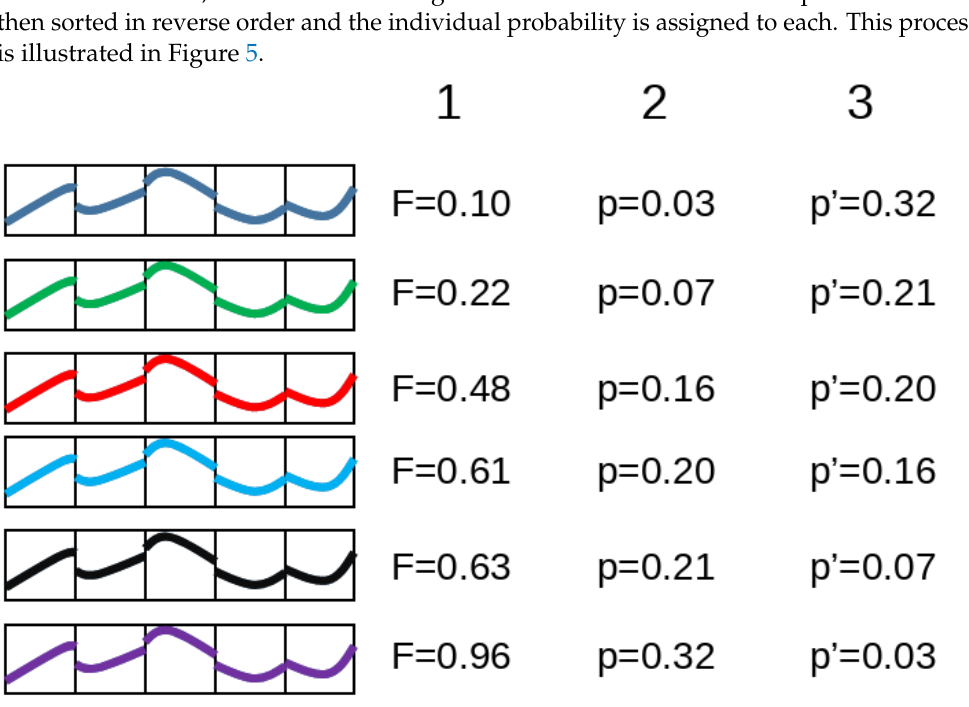
Figure 5. An illustration of the roulette wheel selection process. In step (1) the fitness is calculated according to Equation (20) (lower is better). Then, in (2), the probability is calculated as the percentage of the total population fitness (in the illustration, the total sum of individual fitness is 3.0). Finally, due to the minimization problem being observed, the probability vector is inverted in